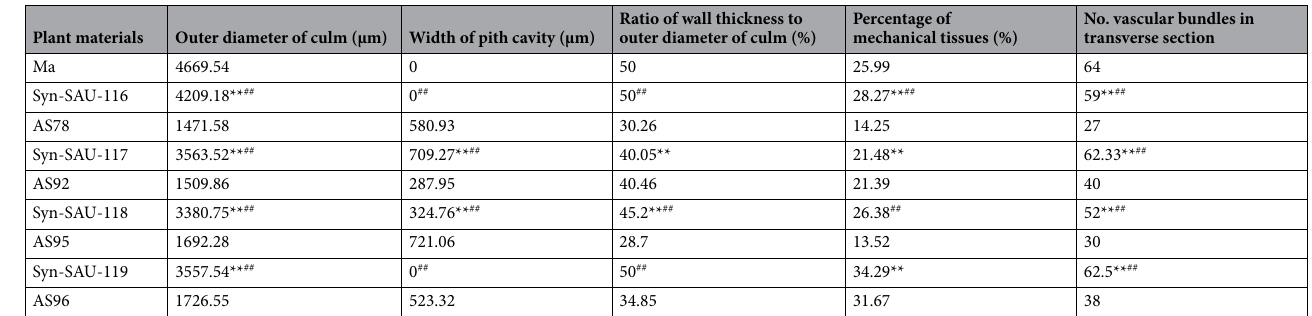
Table 5. Comparisons of stem character of synthetic hexalpoid wheat and their parents in the field. *Significantly different from T. durum Ma at the 0.05 level, **at the 0.01 level; # significantly different from Ae. tauschii at the 0.05 level, ## at the 0.01